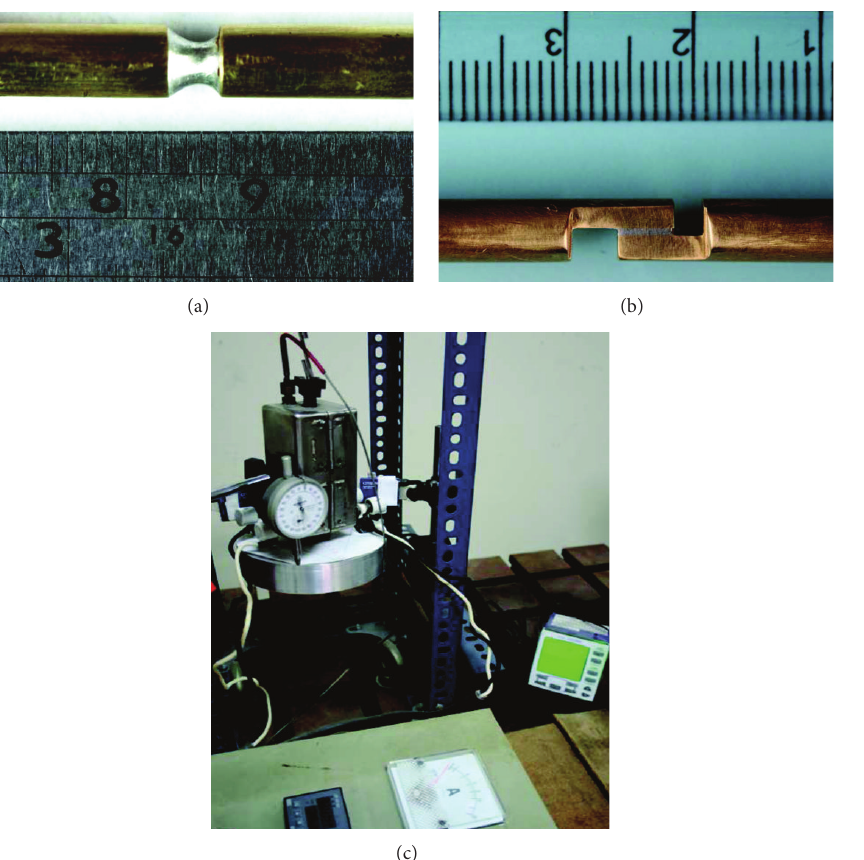
Figure 2: Creep experiment specimen and equipment: (a) tensile creep experiment specimen, (b) shear creep experiment specimen, and (c) creep experiment equipment.